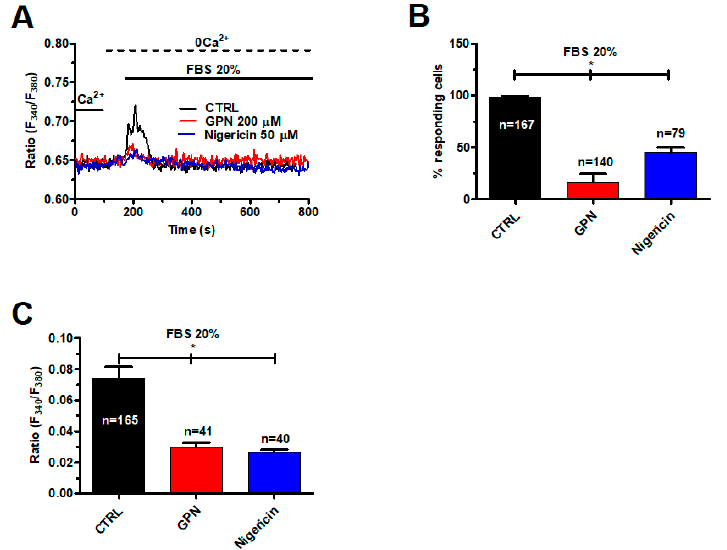
Figure 7. Fetal bovine serum (FBS)-induced intracellular Ca 2+ release is impaired by disruption of acidic stores in mCRC cells. ( A ) intracellular Ca 2+ signals induced by FBS 20% were dramatically reduced upon depletion of the lysosomal Ca 2+ pool with either GPN (200 µM, 30 min) or nigericin (50 µM, 30 min). ( B ) mean ± SE of the percentage of responding cells under the designated treatments. The asterisk indicates p < 0.05. ( C ) mean ± SE of the amplitude of the peak Ca 2+ response to NAADP under the designated treatments. The asterisk indicates p < 0.05.